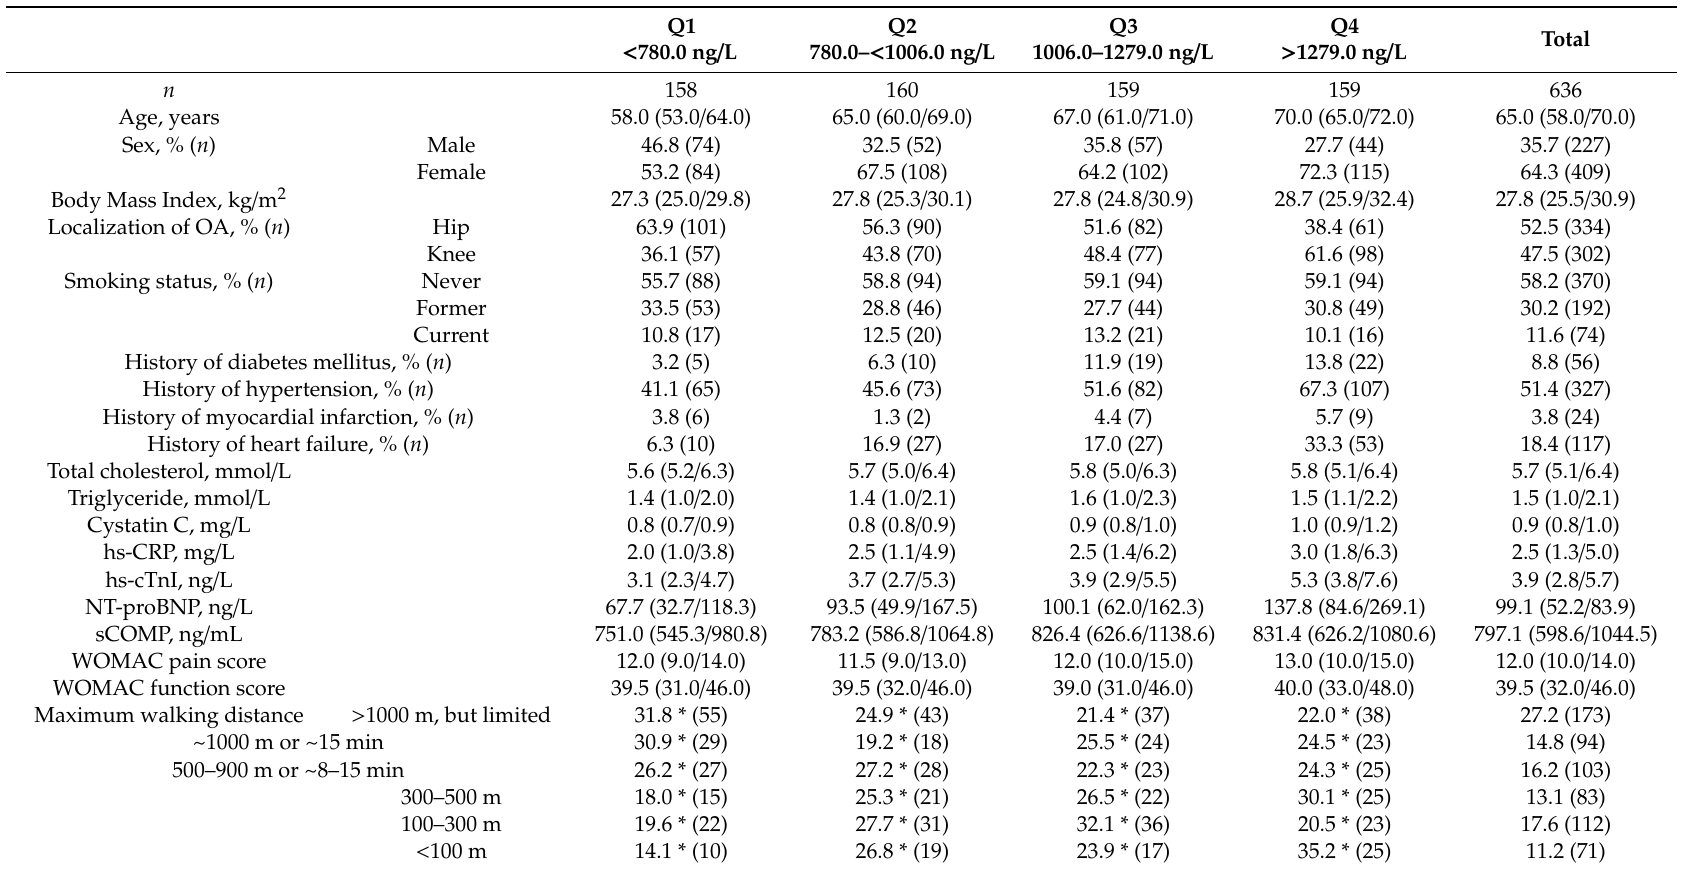
Table 1. Demographic, clinical, and laboratory characteristics of the study participants at baseline by quartiles of